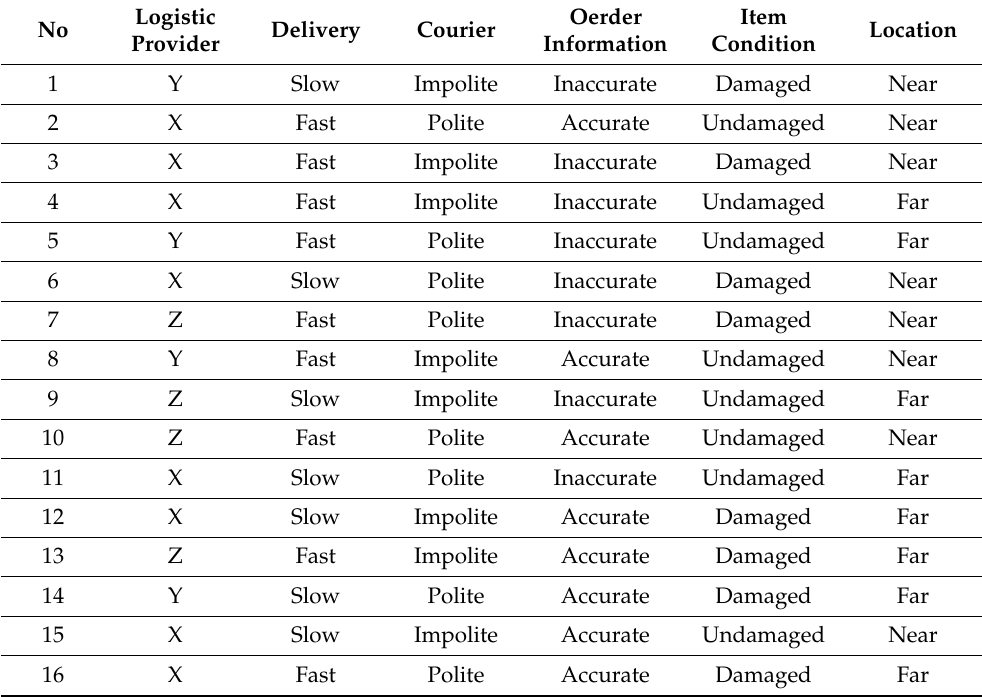
Table 5. Attributes and